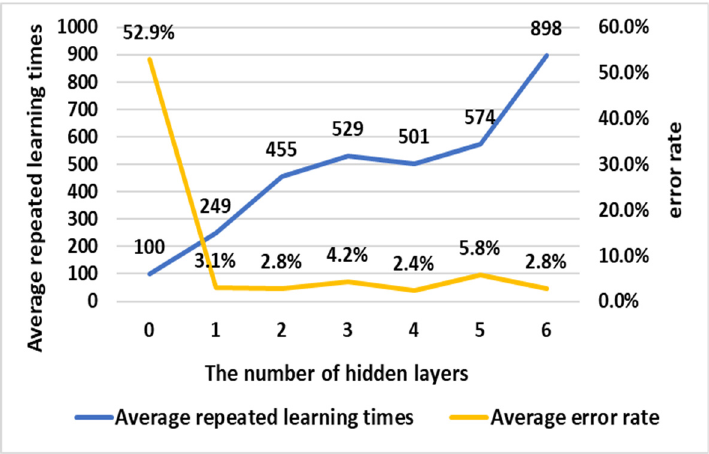
Figure 16. The average repeated learning times and the average error rate of neural network models.